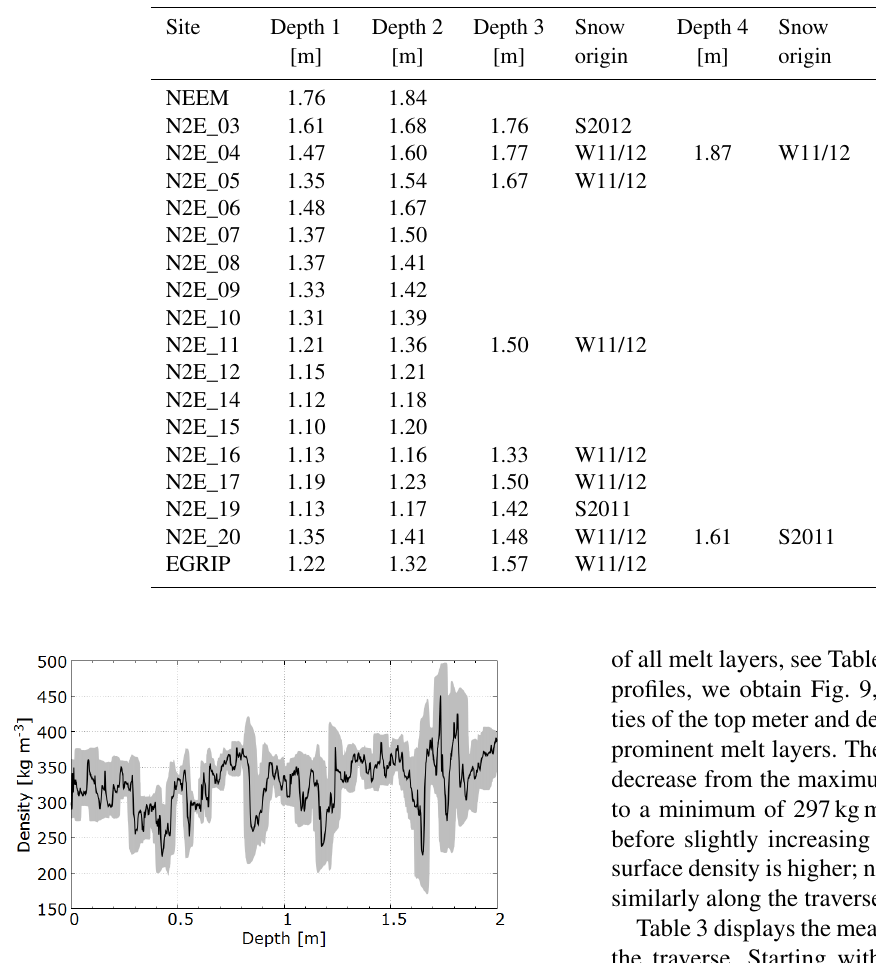
Table 3. Melt layers, the water isotopic season of origin for the surrounding snow and mean annual accumulation rates for each site. The given depths indicate the vertical center of the respective melt layer. The upper two melt layers are always located in snow from summer 2012. For the lower ones, the season of origin for the surrounding snow is given, where S indicates summer and W winter. The accumulation rates are annual mean values for all available years at the particular location.